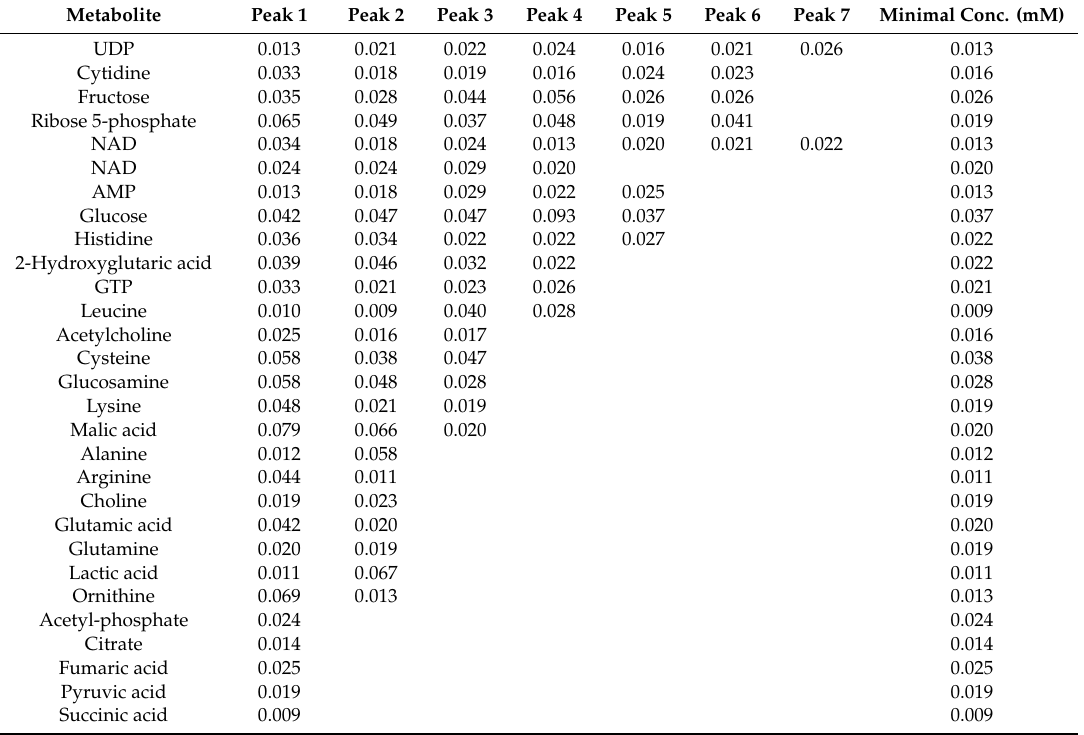
Peak1 through Peak7 refer to the measured resonances for each molecule.